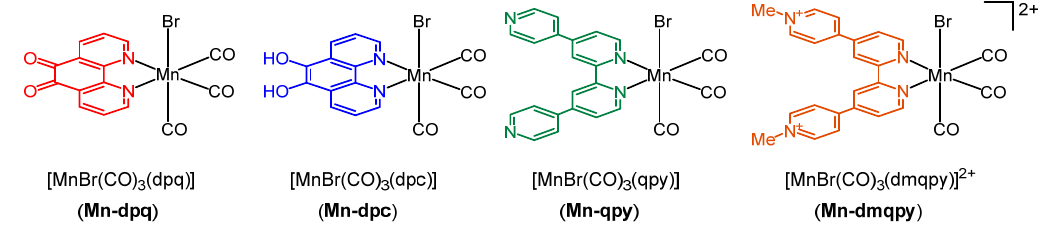
Figure 1. Chemical structures of the Mn(I) complexes presented in this study.